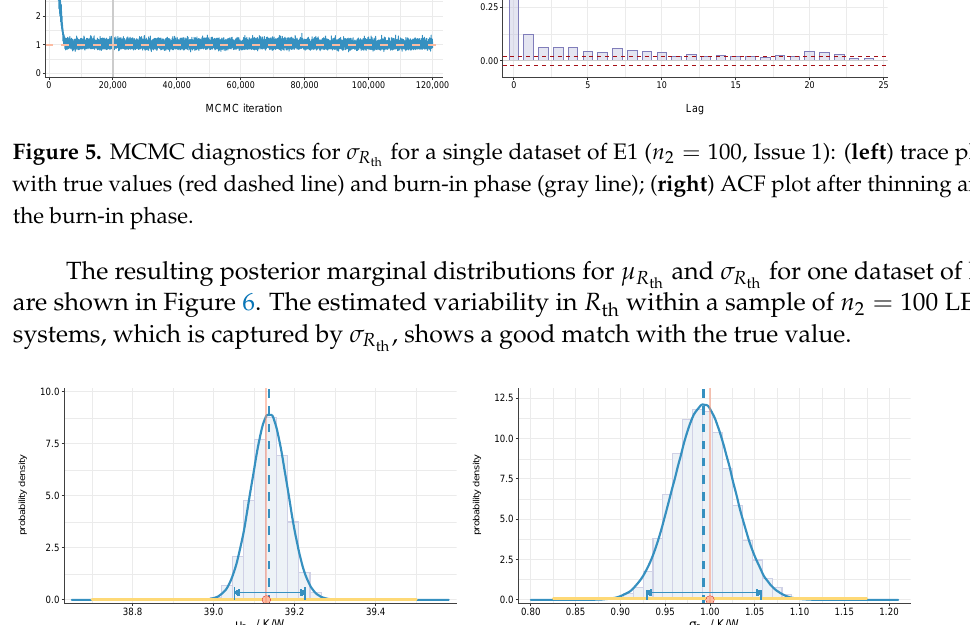
and ( right ) σ R for a single dataset of E1 ( n 2 = 100, Issue 1) th th